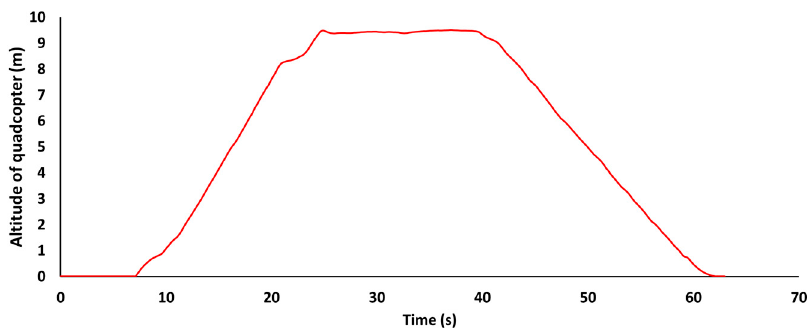
Figure 30. Altitude of the quadcopter during the vertical takeoff and landing.